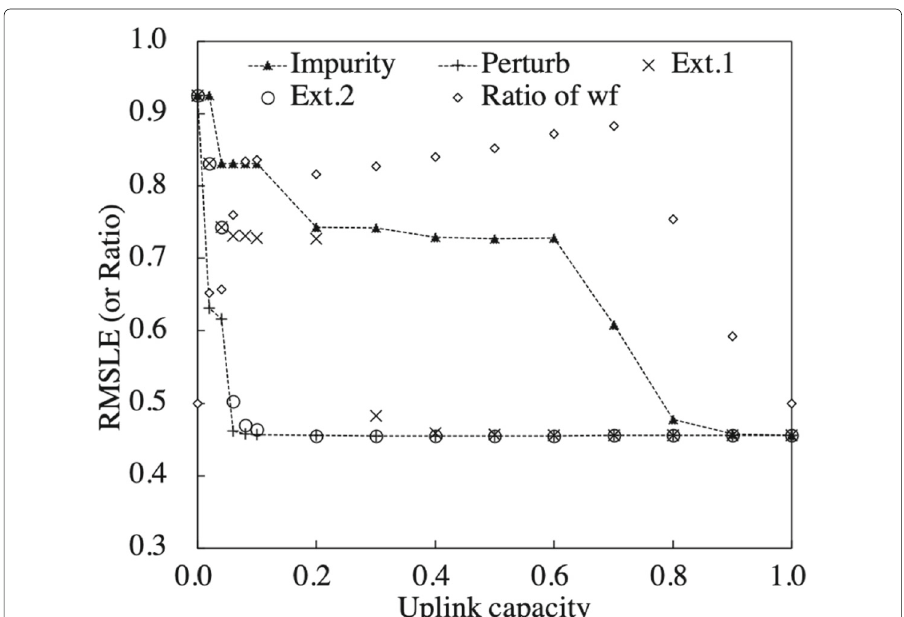
Fig. 12 Prediction accuracy (RMSLE) vs. uplink capacity obtained using RF for prediction. Perturb, impurity, extension scheme 1 with ranking, or extension scheme 2 were used for feature selection. Ratio of w f for perturb to other in extension scheme 2 is also